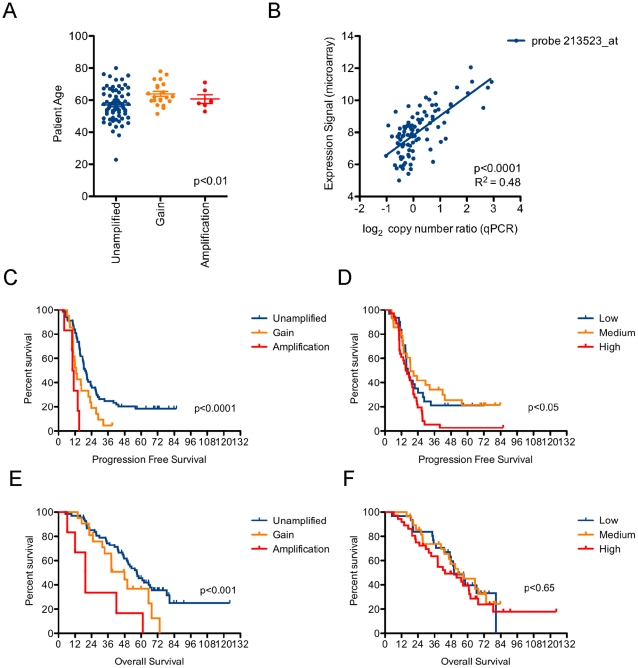

CCNE1 copy number and gene expression associated with patient outcome.(A) Patient age distribution stratified by CCNE1 amplification status. Kruskal-Wallis p-value reported, bars indicate mean and SEM. (B) Correlation between CCNE1 copy number by qPCR and gene expression signal by microarray. (C) Kaplan-meier analysis of CCNE1 unamplified (n = 68), gained (n = 21) and amplified (n = 6) ovarian cancer patients and (D) CCNE1 low (n = 31), medium (n = 28) and high (n = 36) expressing samples for progression-free survival and (E & F) overall survival. Log-rank test p-values reported. Stratification by CCNE1 copy number or expression status described in Materials and Methods.